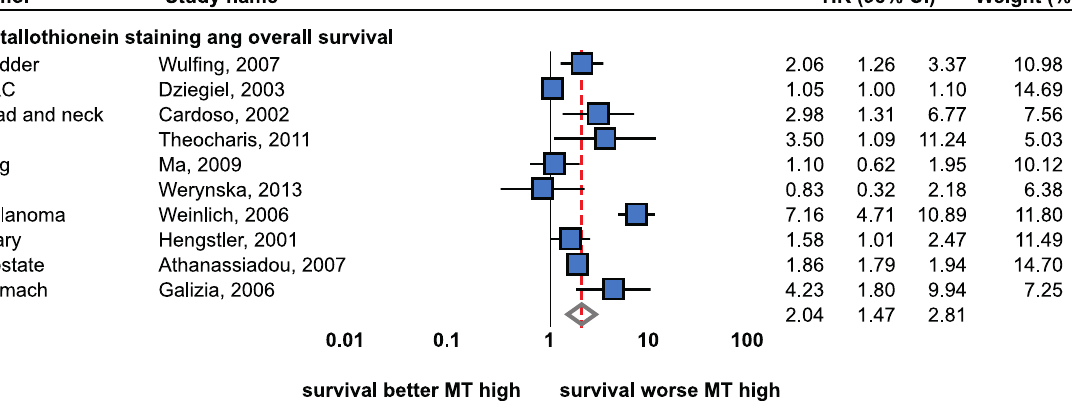
Figure 6. Forrest plot of studies reporting the association of metallothionein staining and the overall survival. Analysis based on Cox- proportional hazard model. Random effects model used. Relative weight of individual studies displayed in %. For more detailed results see Table 1 and 2. Sorted alphabetically by tumor types. Forrest plot displayed as hazard ratio and 95% confidence intervals. Red dashed line indicates the result for all studies together. HR, hazard ratio; CI, confidence interval.